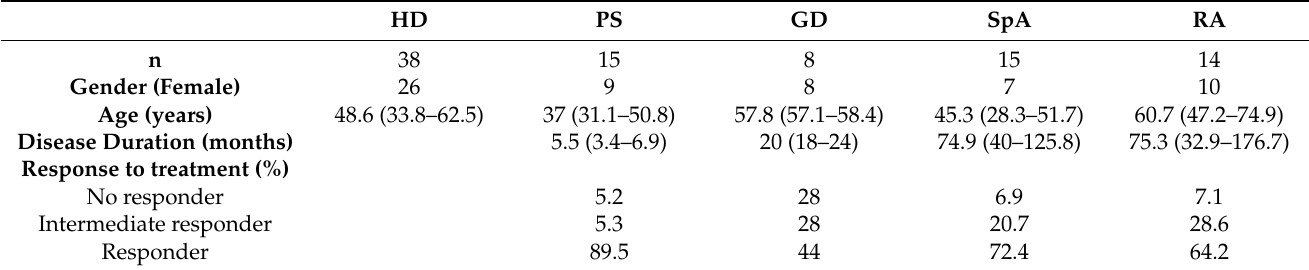
Table 1. Clinical features of patients.